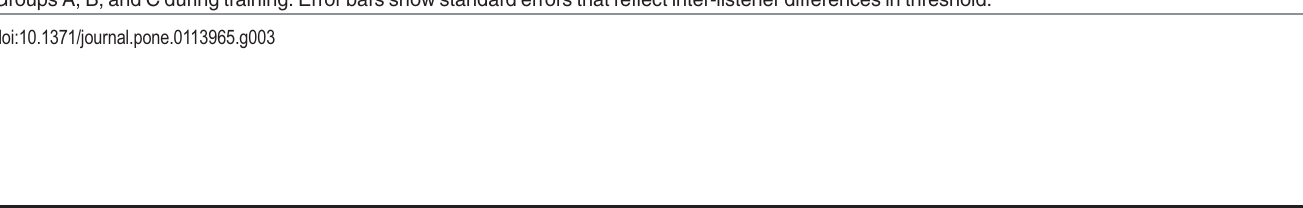
PLOS ONE | DOI:10.1371/journal.pone.0113965 March 2,